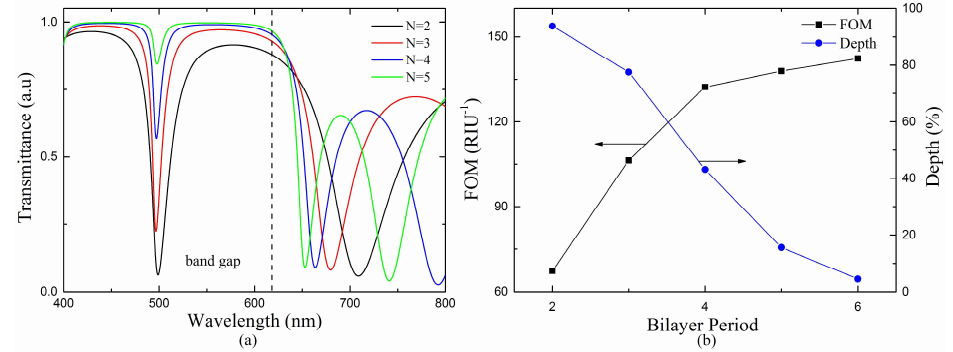
Figure 7. ( a ) Transmission spectra of the proposed sensor with different bilayer periods at n s = 1.37, λ 0 = 1000 nm, d m = 35 nm. ( b ) The depth of resonance dip and FOM of the proposed sensor with respect to various bilayer period at n s = 1.37.